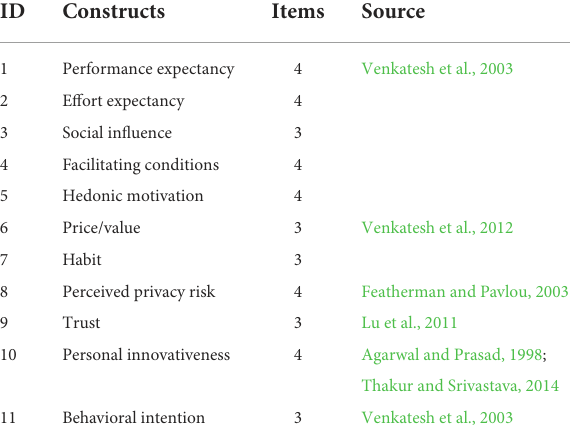
TABLE 2 Variables for analysis. Table 4 a descriptive sociodemographic data of the sample is